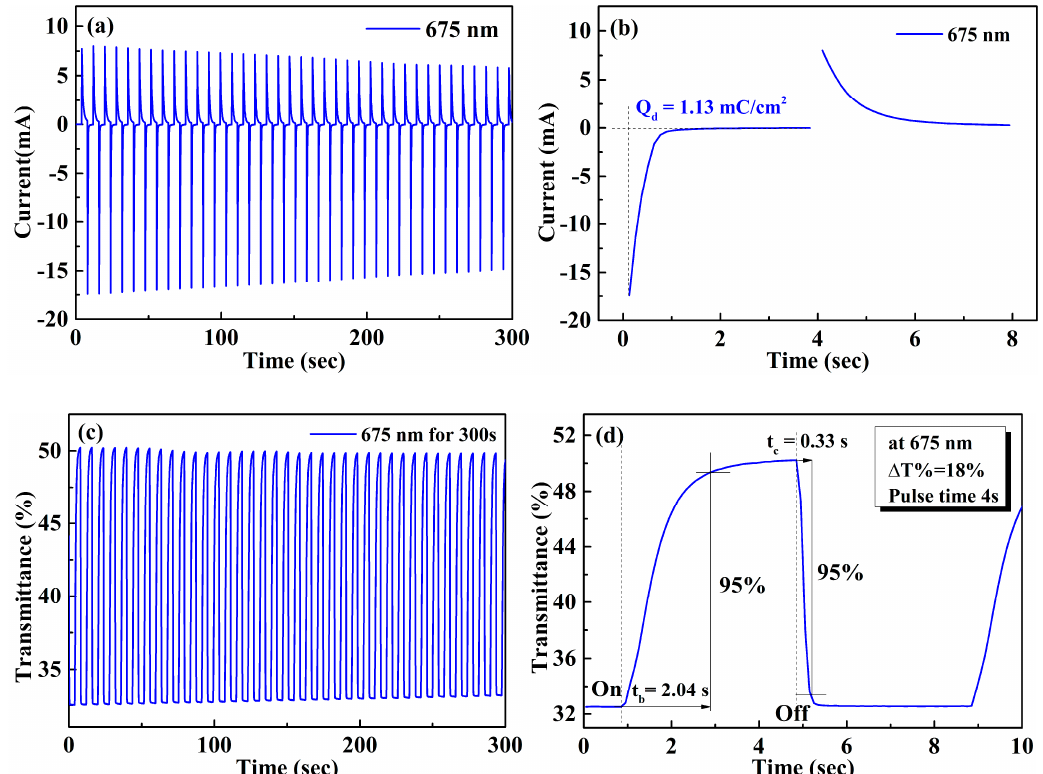
Figure 6. ( a ) Current–time switching curve of PITID-2 film between 0 and 1.35 V in a time interval of 4 s. ( b ) The second cycle of current–time curve. ( c ) Transmittance-time curve of PITID-2 last for 300 s at 675 nm ( d ) The bleaching time ( t b ) and the coloration time ( t c ) of PITID-2 at 675 nm.